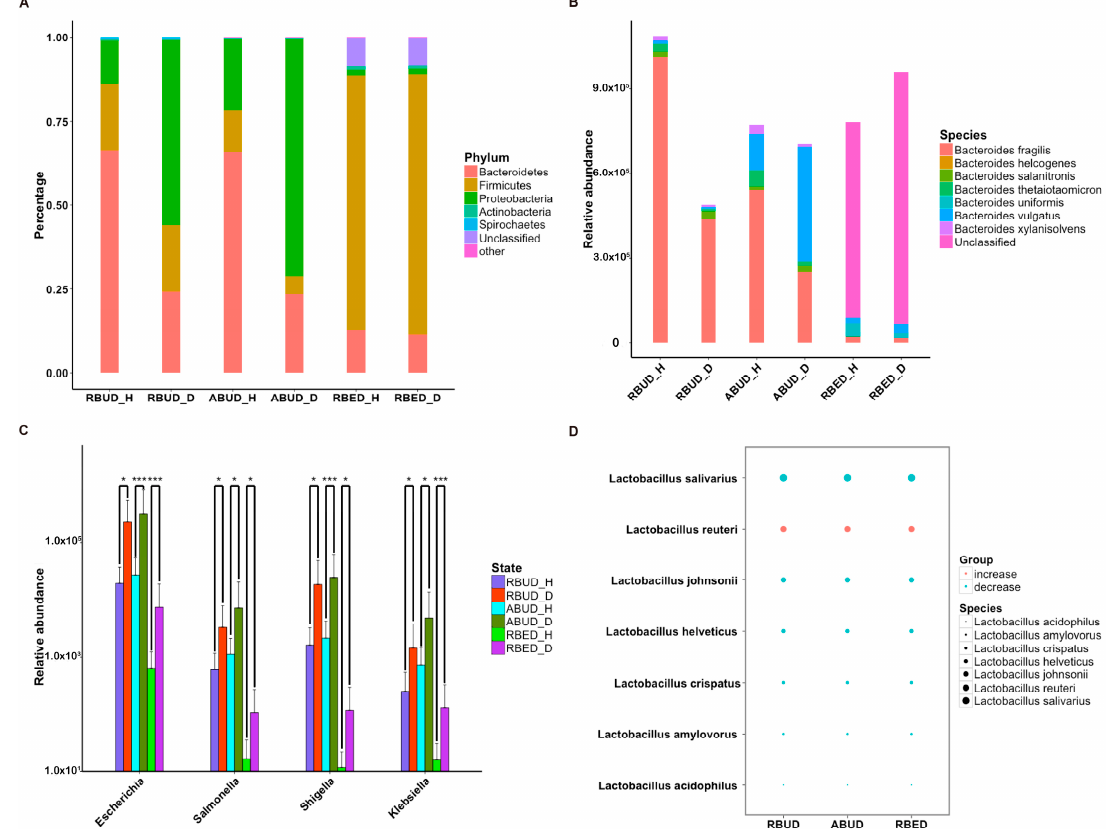
Figure 5. Characteristics of gut microbiota at different taxonomic levels using these three methods in avian colibacillosis. ( A ) The changes of the abundance percentage of gut microbiota between healthy and diseased cases at the phylum level. ( B ) The abundance change of species that belongs to the genus of Bacteroides. ( C ) The significant abundance change of the dominant genus that belongs to Proteobacteria. * adjusted p < 0.05; *** adjusted p < 0.01. ( D ) The trend changes of species abundance between healthy and disease groups detected by the three methods.